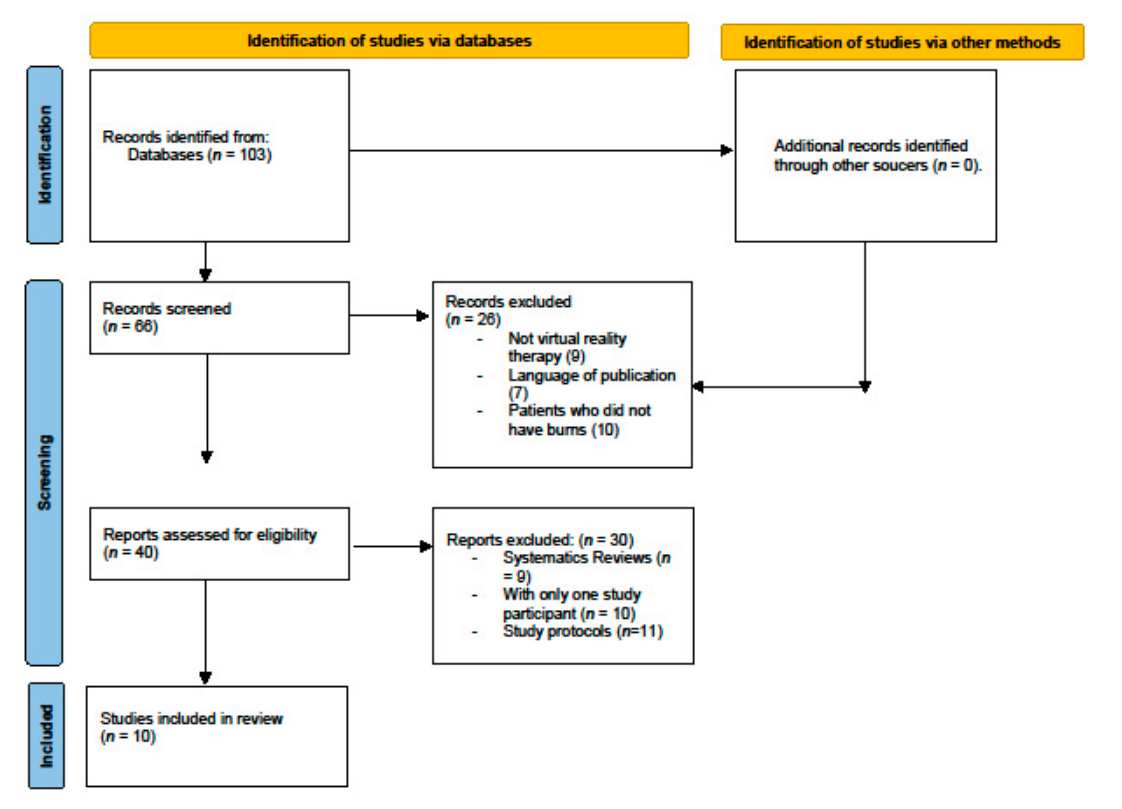
Figure 1. PRISMA Figure 1. PRISMA flowchart.